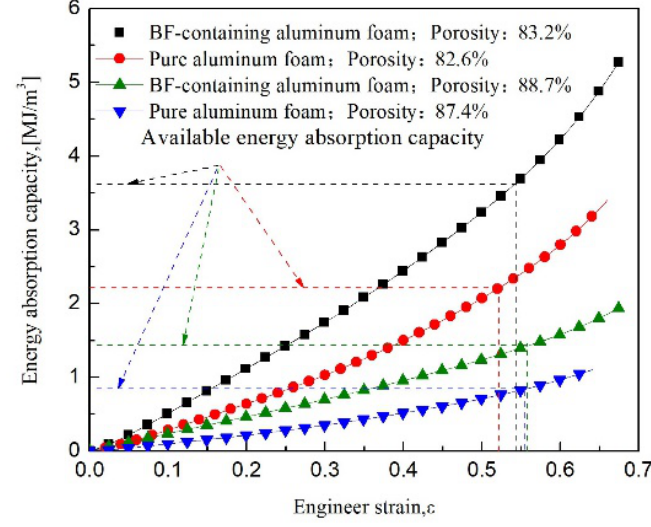
Figure 4. Energy absorption capacity of two kinds of aluminum foams.